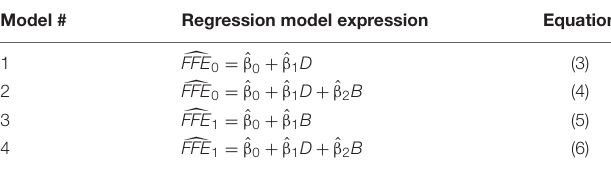
TABLE 4 | Regression models